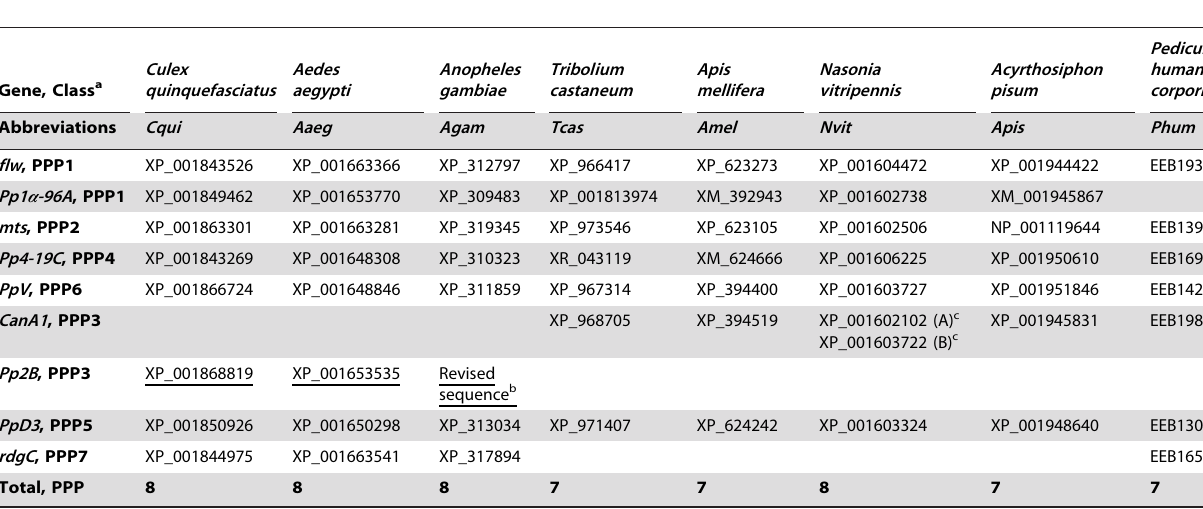
Table 2. Identification of PPP genes in sequenced insect